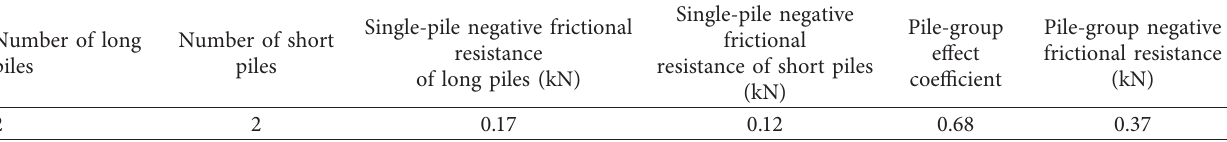
Table 4: Negative frictional resistance Q n g of the pile group consisting of 4 piles.